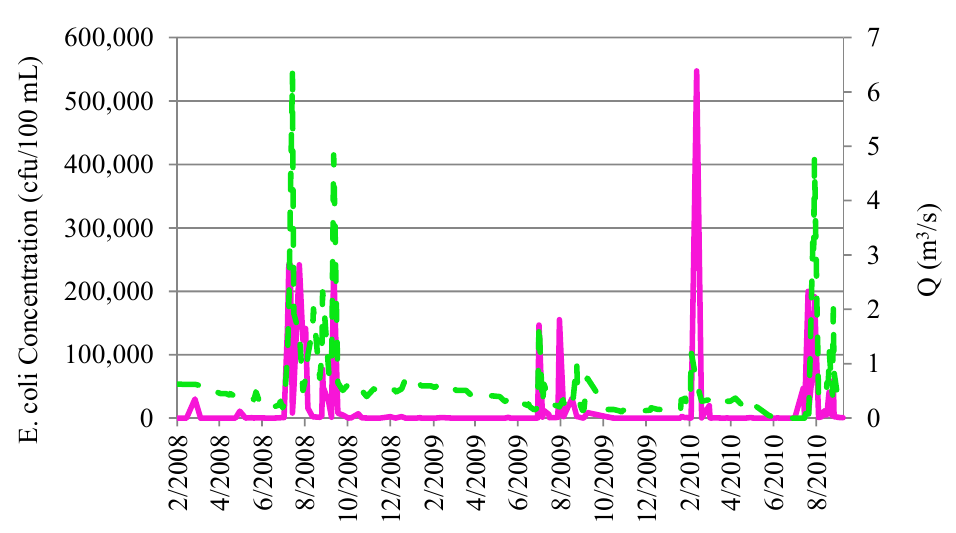
Figure 4. Impact of monthly accumulated rainfall on in-stream fecal coliform concentrations from March 1996 to December